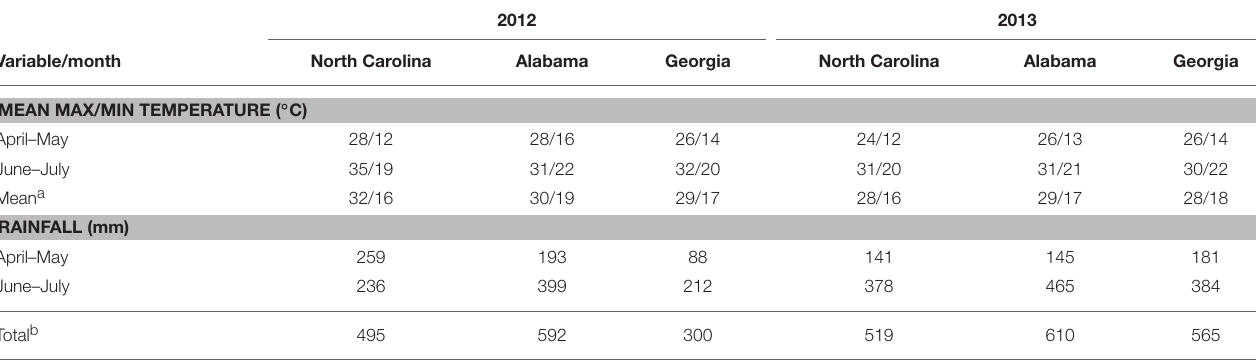
TABLE 1 | Summary of weather variables recorded at experimental sites in a study conducted to assess the impact biocontrol strains on genetic structure of Aspergillus flavus in the